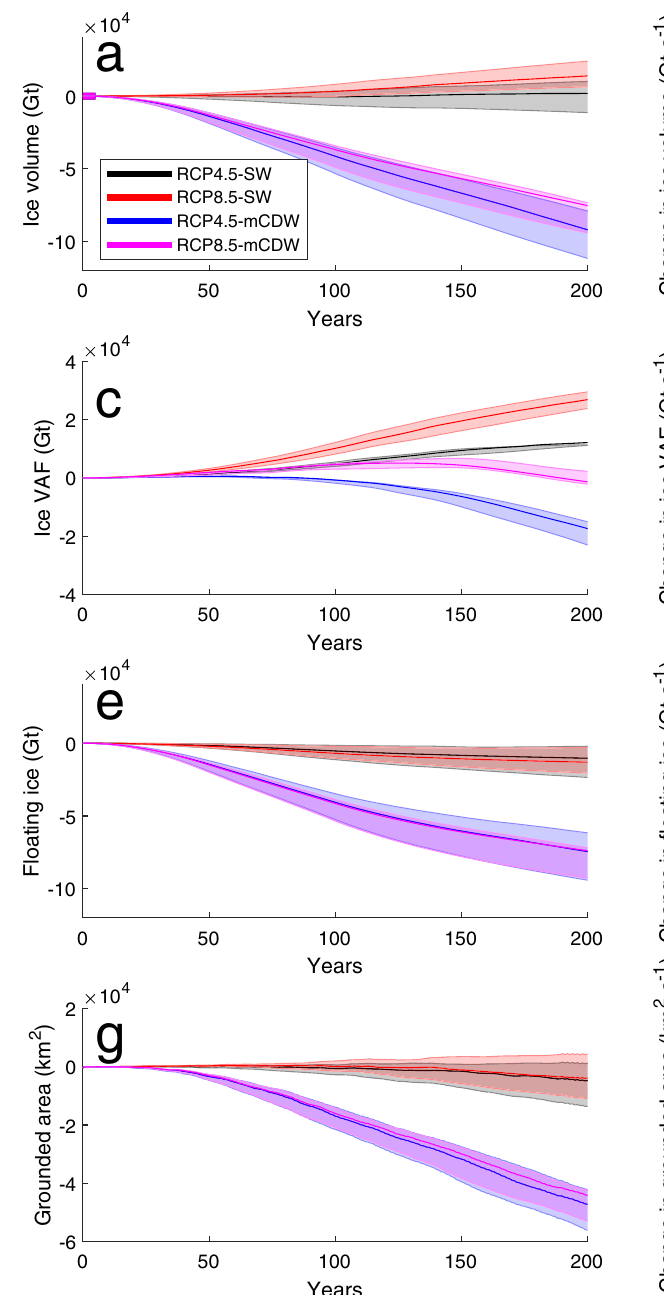
Fig.2|TheEastAntarcticIceSheetoverthenext200years. Total( a )andrateof change ( b ) of ice volume, total ( c ) and rate of change ( d ) of ice volume above fl otation (VAF), total( e ) and rate of change( f ) of fl oating ice, and total( g ) and rate of change ( h ) of grounded area time series of the entire model domain. Repre- sentative Concentration Pathway (RCP) of the climate scenarios and Shelf Water (SW) or modi fi ed Circumpolar Deep Water (mCDW) ocean forcing shown in black